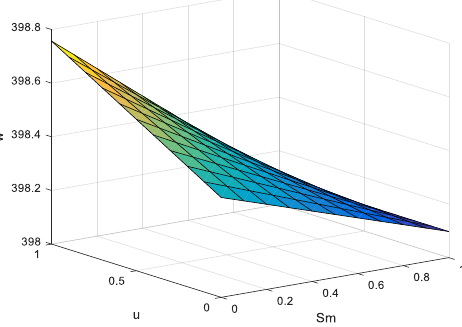
s and  on w . Figure 4. Effect of s m and µ on w m s and  on w . m